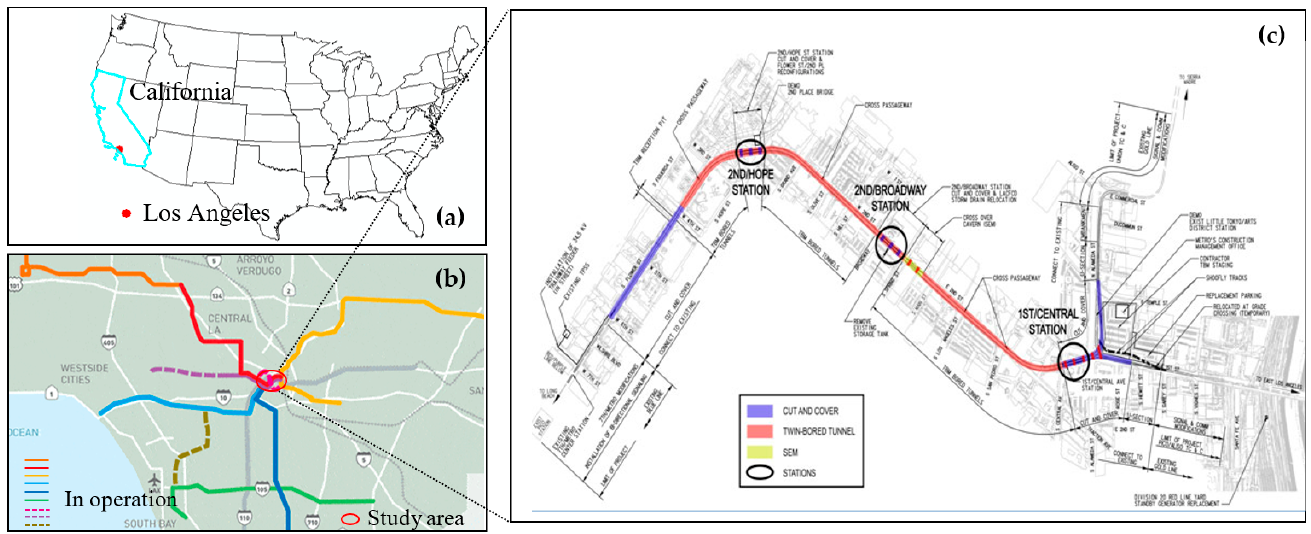
Figure 1. Study site: ( a ) location map of the study area, ( b ) LA county Metro Transit System, and ( c ) project alignment (revised from [23]).